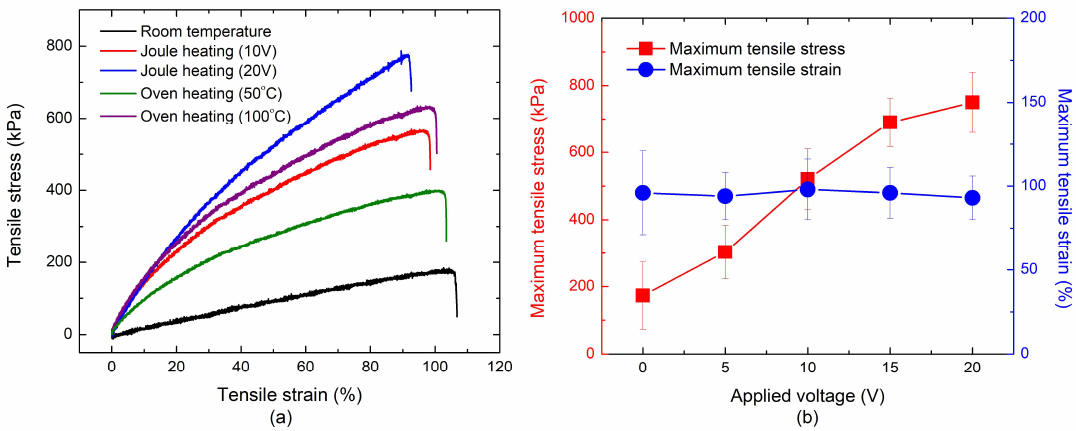
Figure 8. Mechanical properties of CNT nanocomposites cured by oven heating and Joule heating: ( a ) stress-strain curve for direct tensile testing of CNT nanocomposites; ( b ) maximum tensile strength and strain of CNT nanocomposites cured by Joule heating.